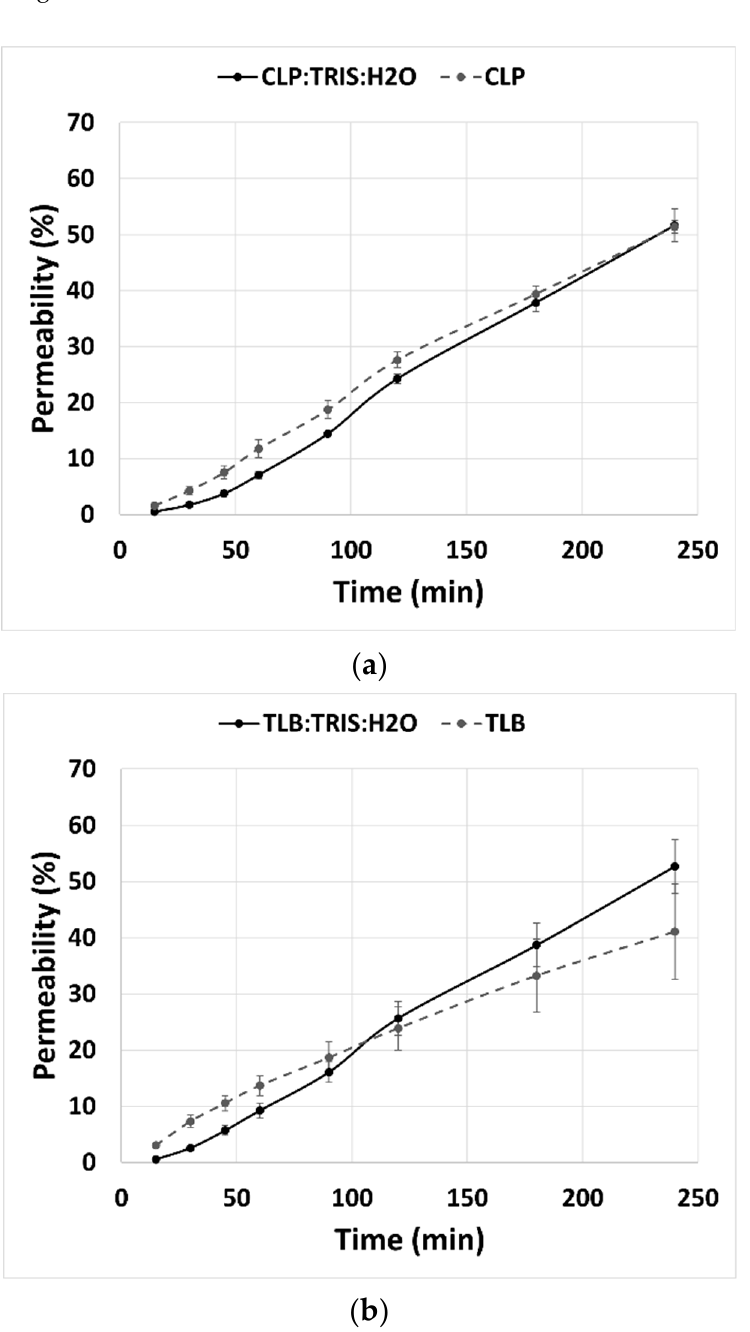
Figure 9. Percentage of permeability for ( a ) CLP−THELES and ( b ) TLB−THELES. Regarding the effect of the THELES in cell lysis, no toxicity was observed for the THELES, and pure APIs (values lower than 30%), for all concentrations tested, with values lower than 8% of cell lysis (Figure